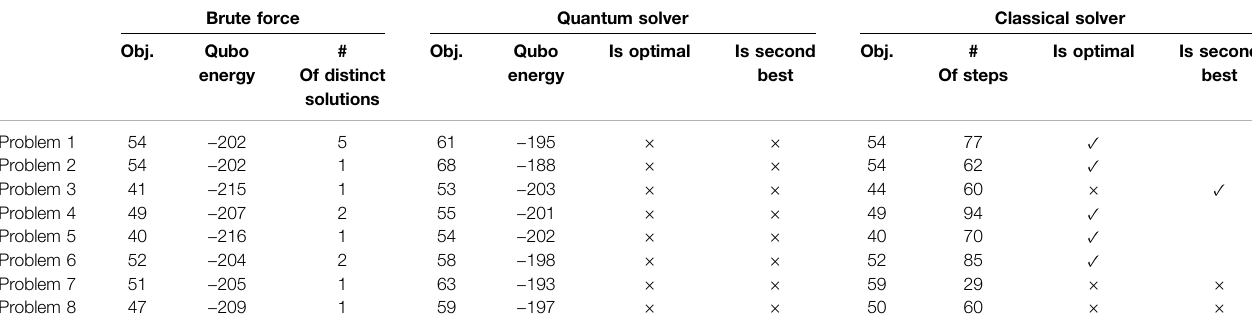
TABLE 1 | Evaluation of quantum algorithm and its comparison to a classical solver as well as brute-force method ( n (cid:2) 8). Brute force Quantum solver Classical solver Obj. Qubo # Obj. Qubo Is optimal Is second Obj. energy Of distinct energy best solutions